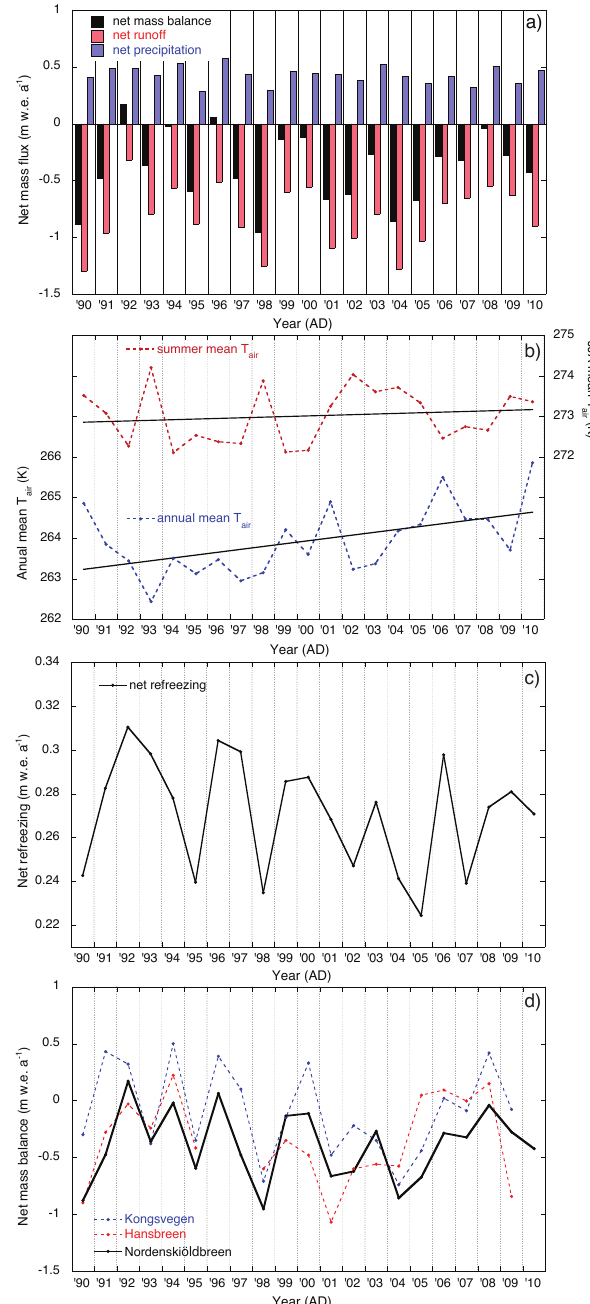
Fig. 7. Time-series over the period 1989–2010 of the net mass bal- ance, precipitation and runoff (a) , spatially averaged annual and summer (JJA) mean air temperatures (b) , net annual refreezing (c) , and the net mass balance for Nordenski¨oldbreen, Kongsvegen and Hansbreen (d) . The years on the horizontal axis represent mass bal- ance years starting at the 1st of October of the preceding year. The location of Kongsvegen and Hansbreen is indicated in Fig. 1. The black lines in (b) mark the linear trend in the annual and summer mean air